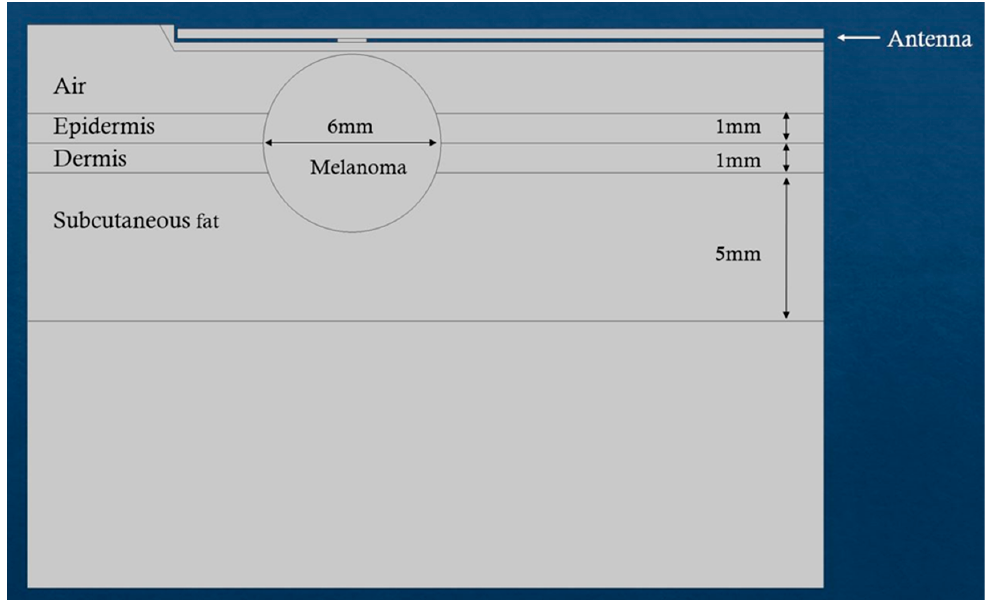
Figure 9. Simulated scenario of microwave-induced hyperthermia for melanoma.